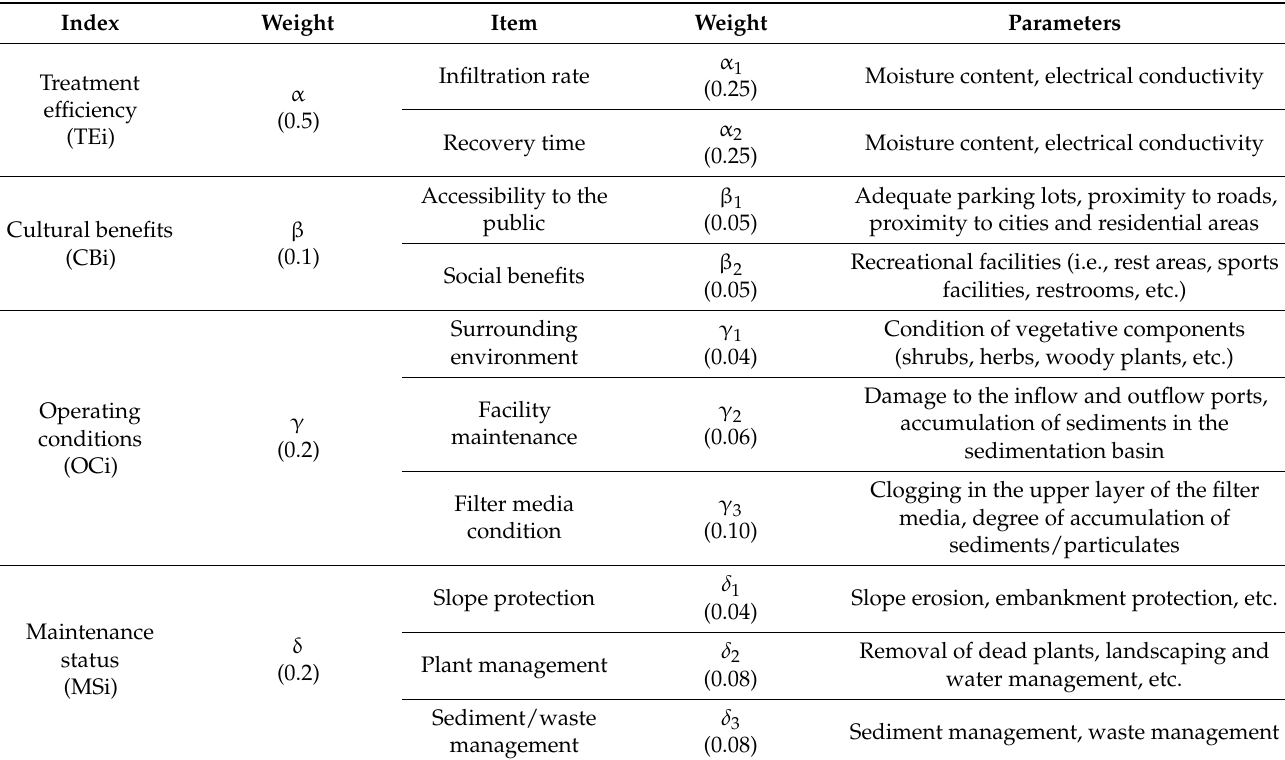
Table 7. List of indices and items used for the comprehensive evaluation of the LID